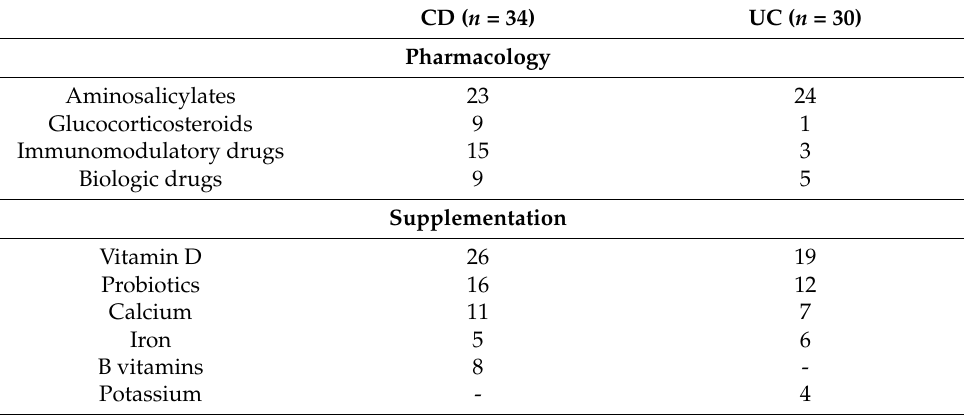
Table 2. Characteristics of the medications and supplements taken in the study